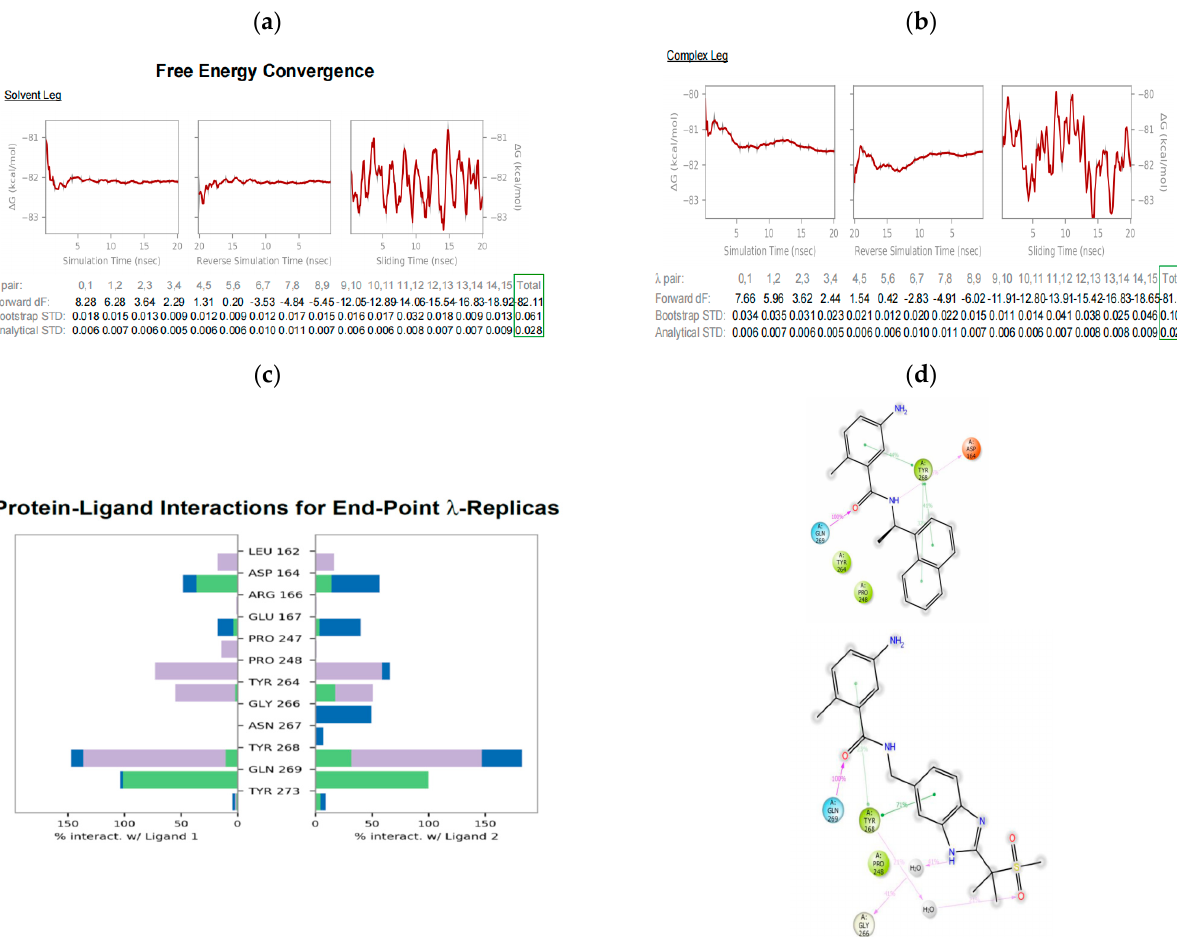
Figure 6. FEP+ simulation results for relative binding affinity prediction for the perturbation cycle of GRL-0617 (ligand 1) and compound 45 (ligand 2). ( a ) Free energy convergence of the perturbation cycle in solvent leg. ( b ) Free energy convergence of the perturbation cycle in complex leg. ( c ) Histo- gram depicting protein–ligand interactions for endpoint λ -replicas. ( d ) Ligand interaction diagram (Ligand 1 at the top and ligand 2 at the bottom) detailing the type of interactions observed between the two ligands and the receptor.